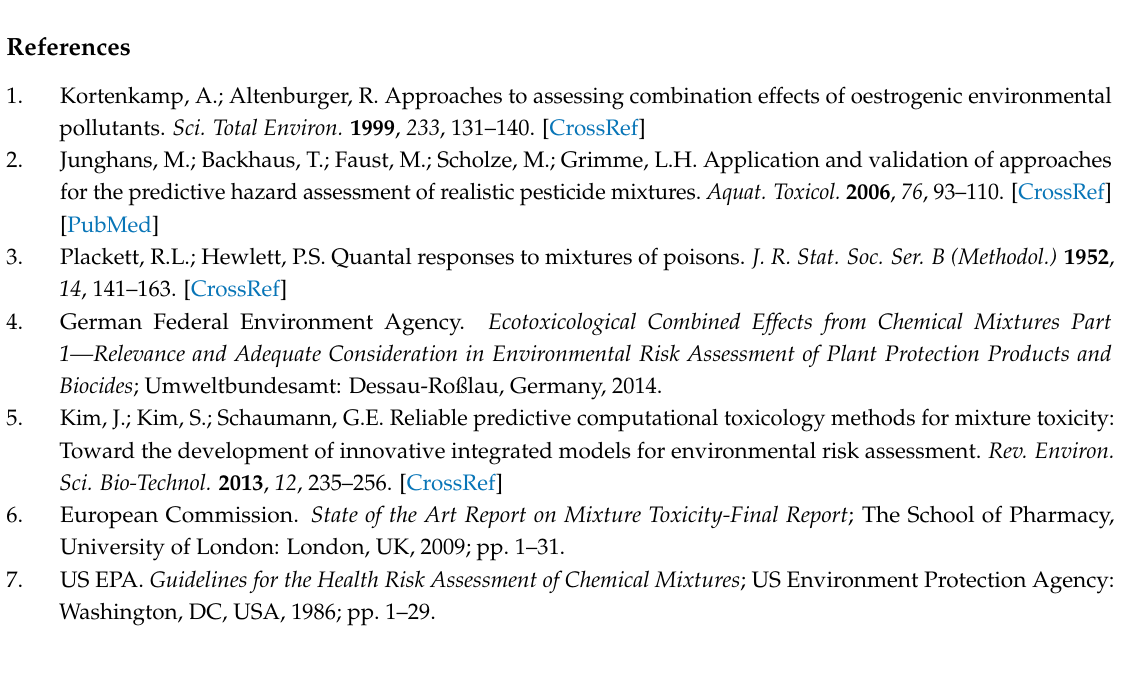
Table S1: Selected pesticides and pharmaceuticals, which were identified in major river basins in South Korea, Table S2: The regression models employed in describing the dose-response curves in this